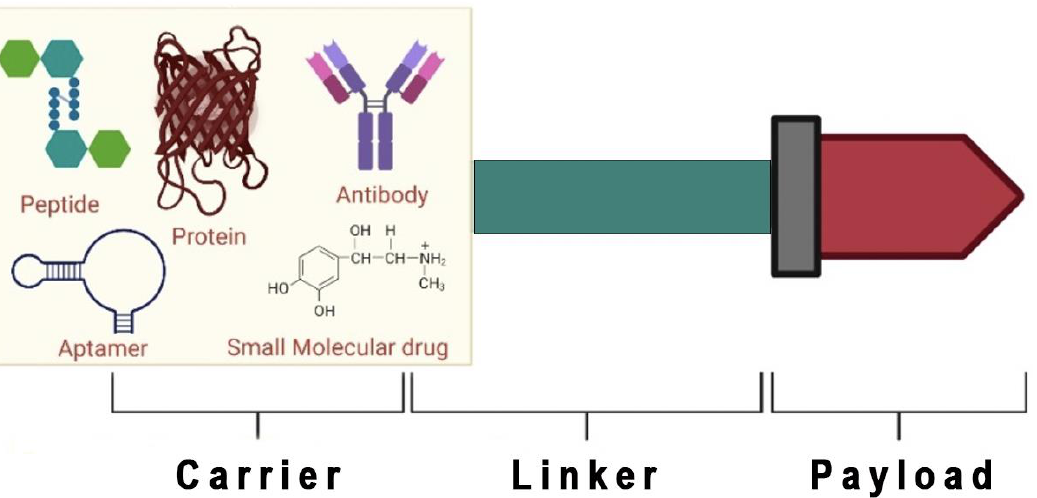
Figure 1. Schematic diagram of the components of peptide-drug conjugates (Created with Bioren- der.Com). Peptide, protein, antibody, small molecular drug, and aptamer is used as a carrier. If a peptide is used as a carrier, it is known as a peptide-drug conjugate. Table 1. Some peptide-drug conjugates against cancer in different developmental